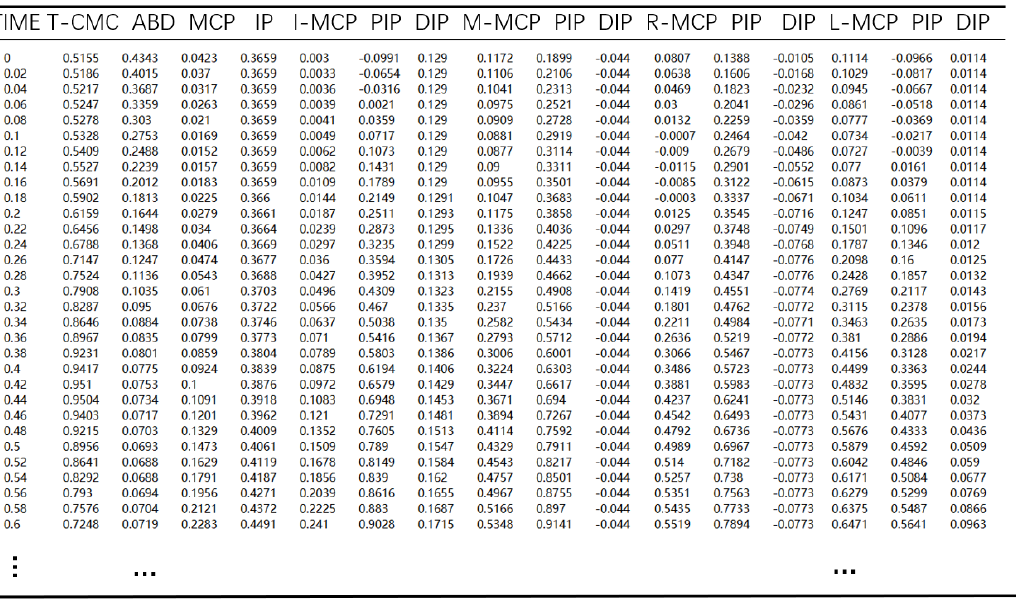
Figure 7. Joint angle data of patient grasping